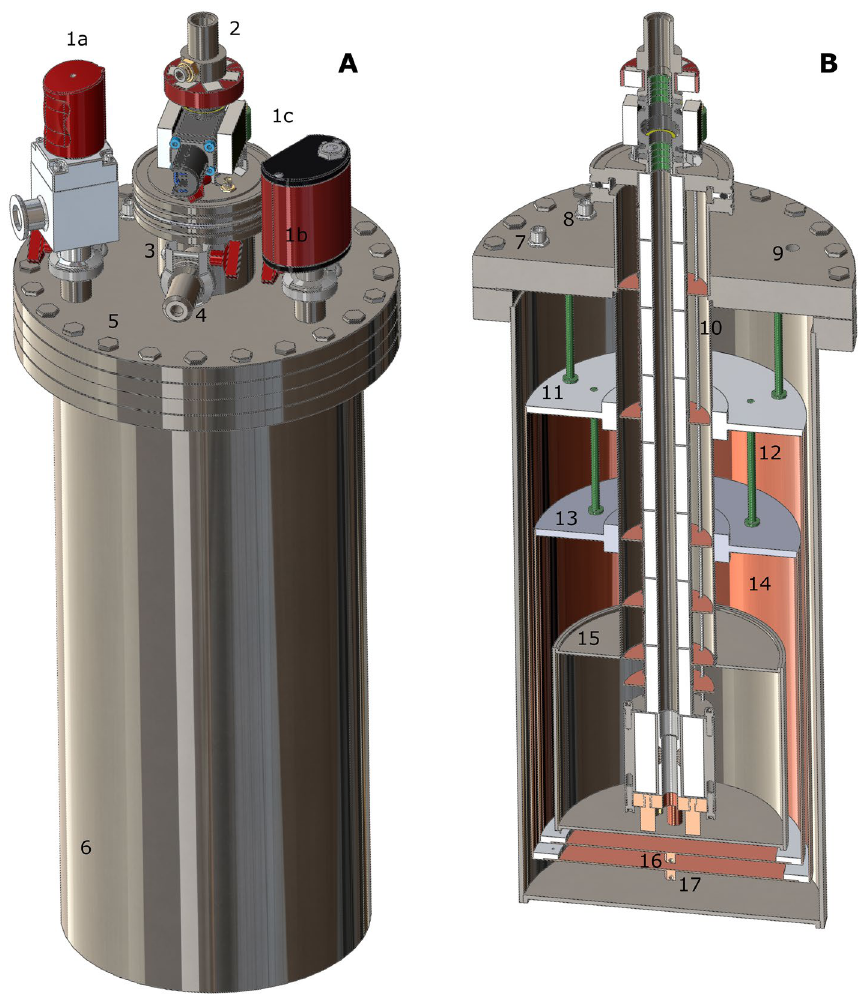
Figure 4. 3D drawings ( A ) and section view ( B ) of the full cryostat with probe. OVC pumping valve (1a); pressure gauge (1b); OVC overpressure valve (1c, not visible); top of the probe (2); ISO-K-63 half-nipple (3); boil off check valve (4); CF-200 top flange (5); OVC (6); outer shield/shield 2 Fischer connector (7); inner shield/ shield 1 Fischer connector (8); dissolution stick M10 threading (9); shields ‘mounting rods (10); outer shield/ shield 2’s heat exchanger (11); outer shield/shield 2 (12); inner shield/shield 1’s heat exchanger (13); inner shield/ shield 1 (14); He pot (15); inner shield/shield 1’s temperature sensor (16); outer shield/shield 2’s temperature sensor